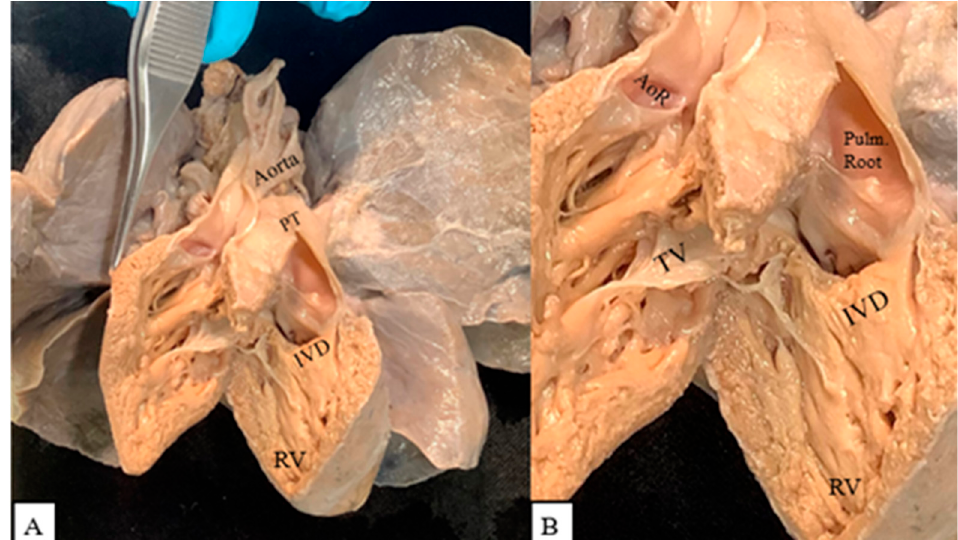
Figure 1. ( A ) Double outlet right ventricle with subpulmonary interventricular defect (IVD). PT: pulmonary trunk; RV: right ventricle. ( B ) Both arterial roots arising from the right ventricle. AoR: aortic root; Pulm. Root: pulmonary root; TV: tricuspid valve.